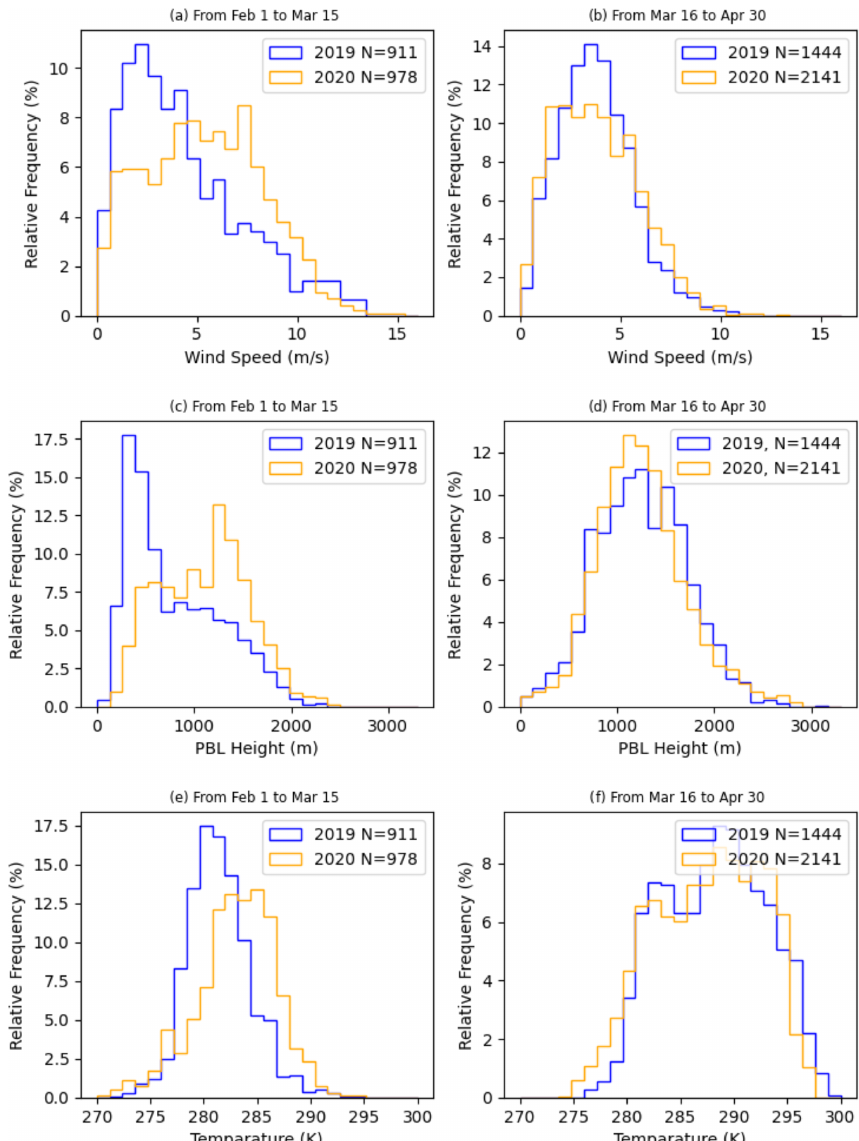
Figure 2. Probability density functions of 10m wind speed (ms − 1 ; a, b ), planetary boundary layer (PBL) height (m; c, d ), and 2m temper- ature (K; e, f ) from the ECMWF operational forecasts for European periods before (a, c, e) and after 15 March (b, d, f) , comparing 2020 to 2019. Distribution is computed for urban areas above 0.5 million inhabitants between 45–60 ◦ N, 10 ◦ W–20 ◦ E, at the S5P overpass times. N is the sample size for each distribution that can be multiplied by the relative frequency (in %) to obtain the absolute